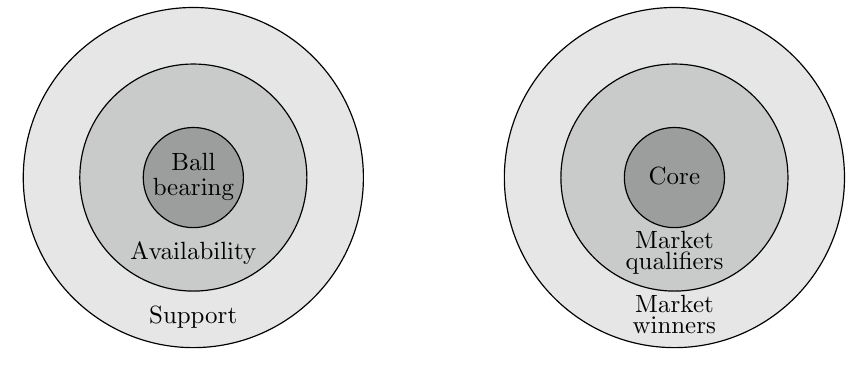
Figure 8: An illustration of the notion of “perceived customer value” (Ericsson